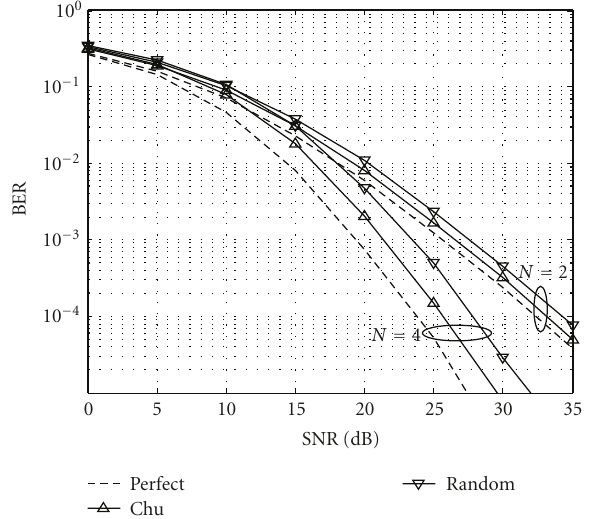
Figure 4: BER performance comparison of the proposed channel estimation method using di ff erent training sequences.